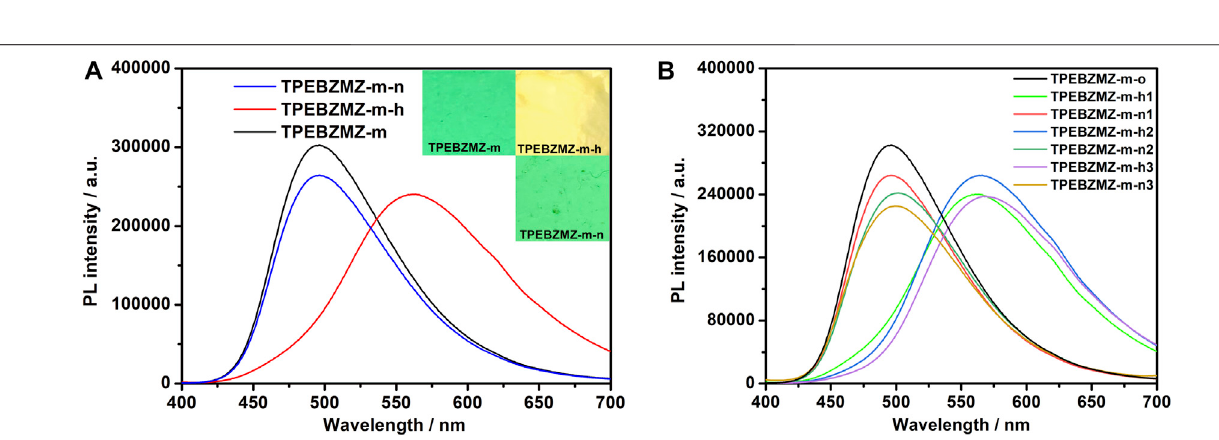
fi lmfrom TPEBZMZ-m-h (NH 3 -fumed (15 min) 3 gas